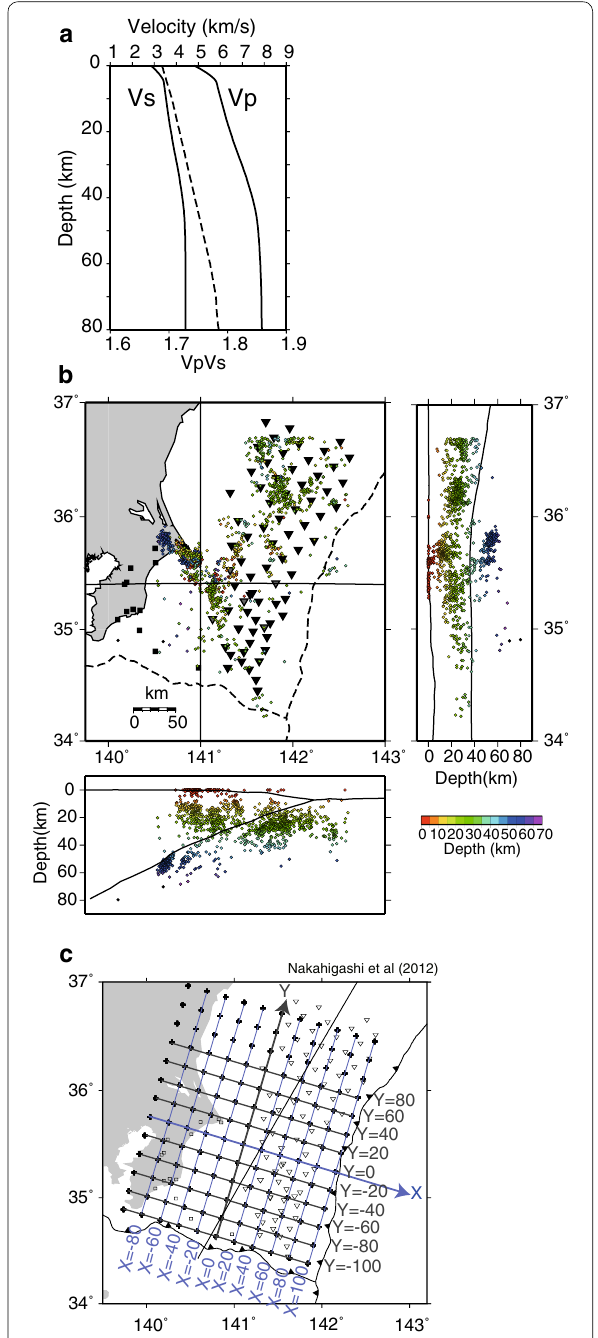
Fig. 2 Initial velocity model and hypocenter distribution and grid configuration during tomographic inversions. a One-dimensional JMA2001 velocity model (Ueno et al. 2002) used for initial hypocenter determination and initial model for tomographic inversion. Bold and dashed lines show the velocities and V p / V s ratio of the model. b Relocated hypocenters based on the one-dimensional model shown in ( a ). Colored dots represent hypocenters. Colors indicate hypocenter depth. Black triangles and squares indicate station locations. Lower and right-hand panels show E–W and N–S vertical sections, respec- tively. PAC upper boundaries (Nakajima et al. 2009) are shown along the latitude of 35.4°N and longitude of 141°E, on the E–W and N–S vertical sections, respectively. c Configuration of grid nodes during tomographic inversions. Crosses represent locations of velocity nodes in horizontal section. Triangles and squares indicate the locations of stations. Black bold line shows the locations of refraction survey (Nakahigashi et al.